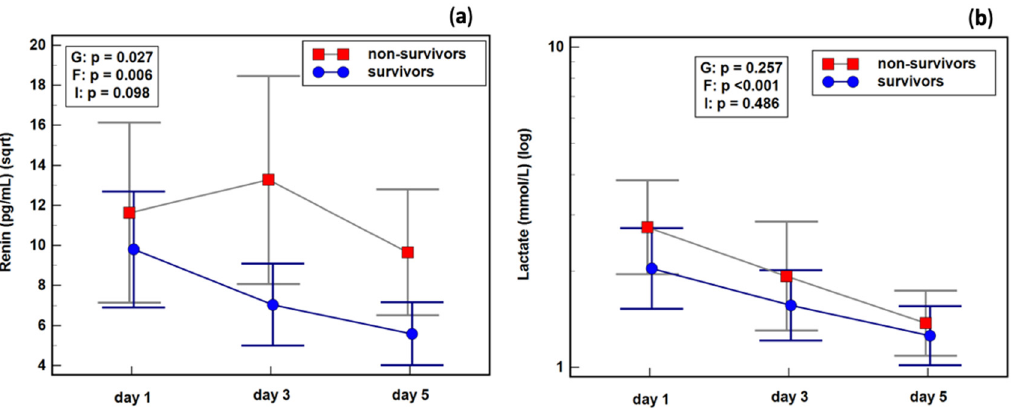
Figure 8. The Kaplan–Meier survival curves for septic patients stratified based on renin concentration: ( a ) assessed on the third day; ( b ) assessed on the fifth day.